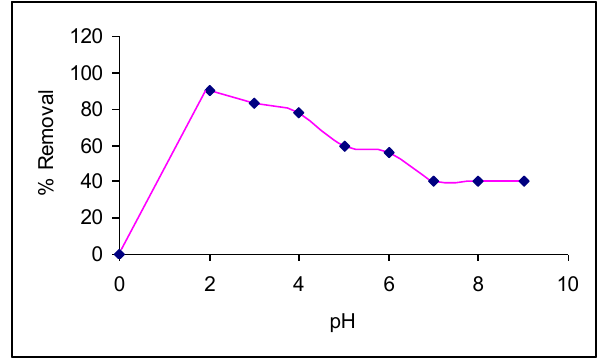
Figure 1. Relationship between pH and % removal of chromium (VI)